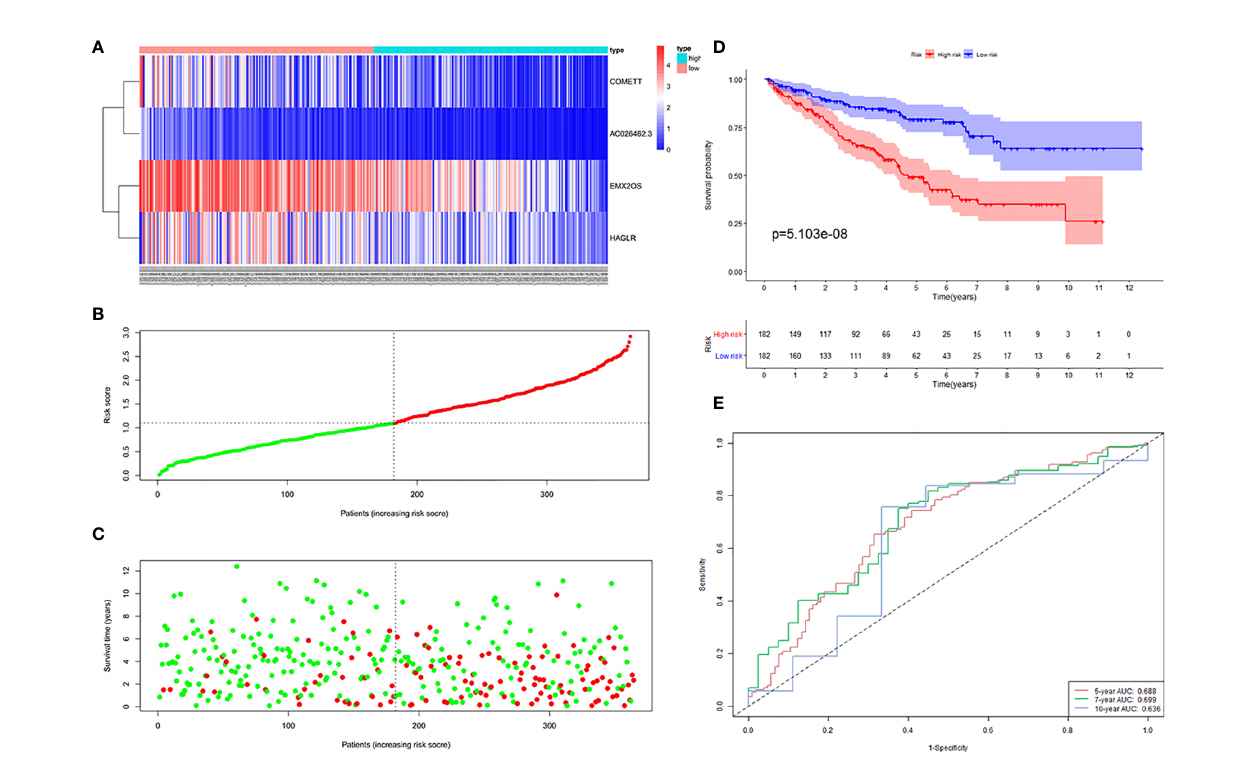
FIGURE 3 | Four hypoxia-related lncRNA signature validated in the training cohort (n = 364). (A) Expression values of the four signature lncRNAs. The colors from red to blue correspond to the expression of a lncRNA from high to low. The risk score (B) and survival status (C) of each ccRCC patient distributed in low- and high- risk groups. (D) KM survival analysis between the high-risk group and low-risk group. The lower layer demonstrates the number of alive ccRCC patients in each group. (E) Time-dependent ROC curves of the